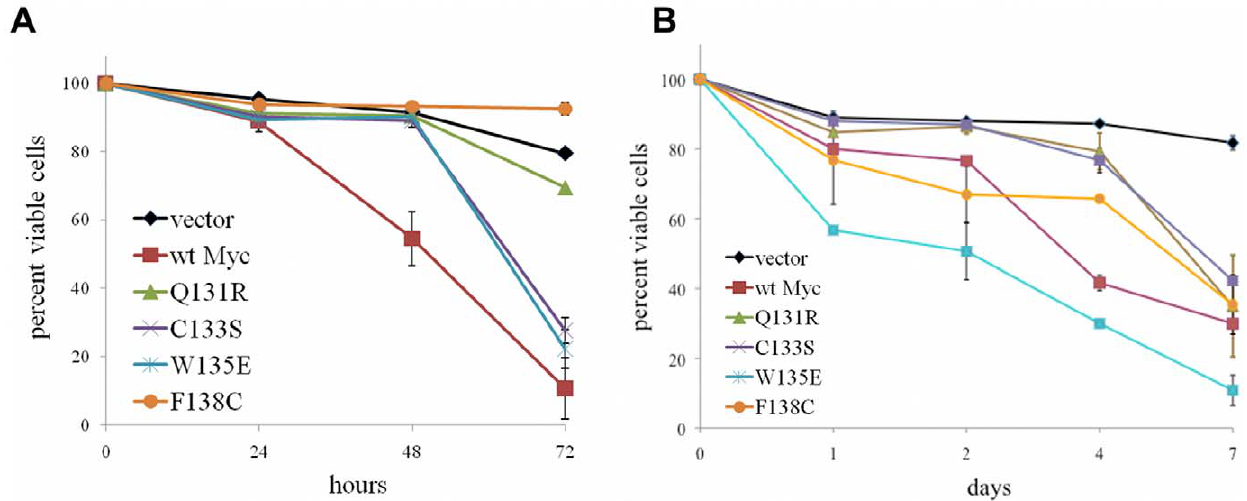
Figure 3. Cell death mediated by Myc proteins. The indicated Rat1a cell lines were seeded into 12 well pates at 10 5 cells/well and allowed to achieve approximately 80% confluency. At the indicated times, viable cell numbers in triplicate plates were determined by flow cytometry using an Annexin V-Propidium Iodide staining protocol as described in Materials and Methods. The results represent the average amount of staining for the triplicate samples + / 2 1 SE. The experiment was repeated on at least three occasions with similar results. ( a ) Serum withdrawal. The cells were washed in PBS and incubated in serum-free medium for the remainder of the study. ( b ) Glutamine withdrawal. The cells were washed in PBS and incubated in glutamine-free medium for the remainder of the study.